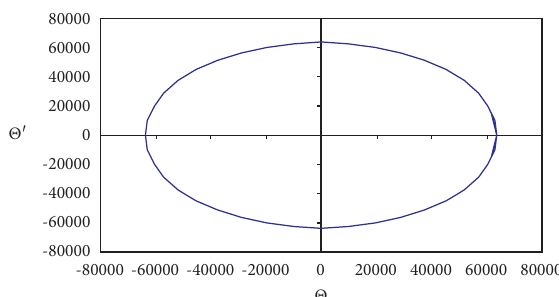
Figure 28: The analytical solution Φ for case (iii) in Section 4.2.